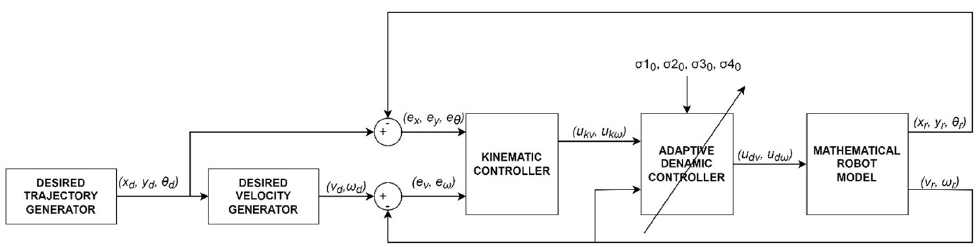
Figure 9. Block diagram of the TURTLEBOT 2 robot’s tracking motion simulation.